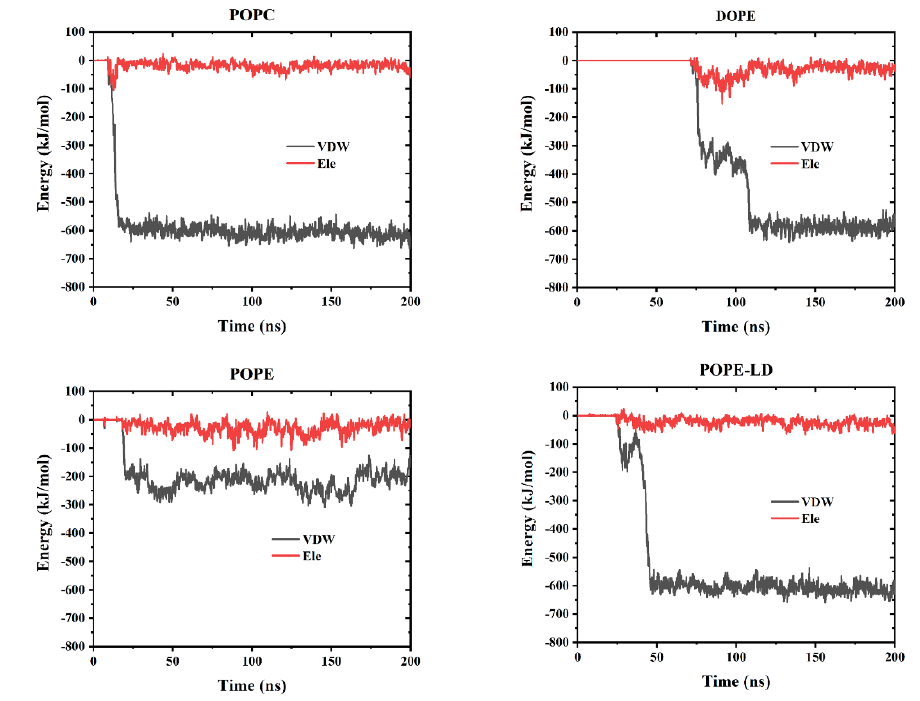
Figure 8. The interaction energy between GQDs and cell membranes includes van der Waals inter- action (VDW) and classical interaction (Ele).